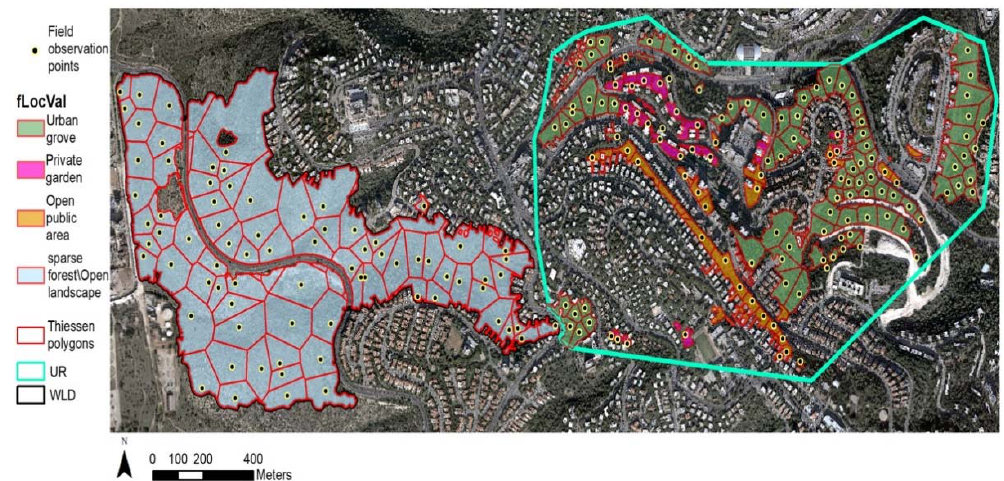
Figure A2. The 212 Thiessen polygons in the WUI burnt area used to map the environmental factors used in i ‐ Tree model for the spatially distributed economic loss calculations.